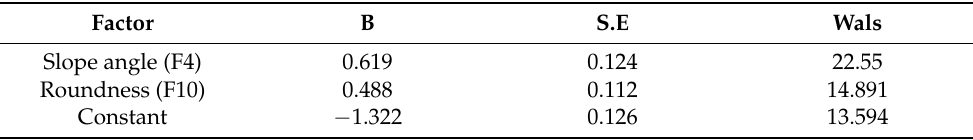
Table 2. Regression coefficients of the LR model.